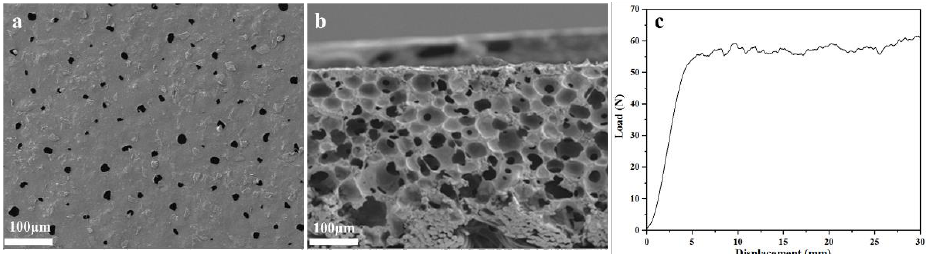
Figure 5. SEM images of surface ( a ) and side section ( b ) for synthetic leather base prepared with WPUR1. ( c ) Load-displacement curve of synthetic leather base.